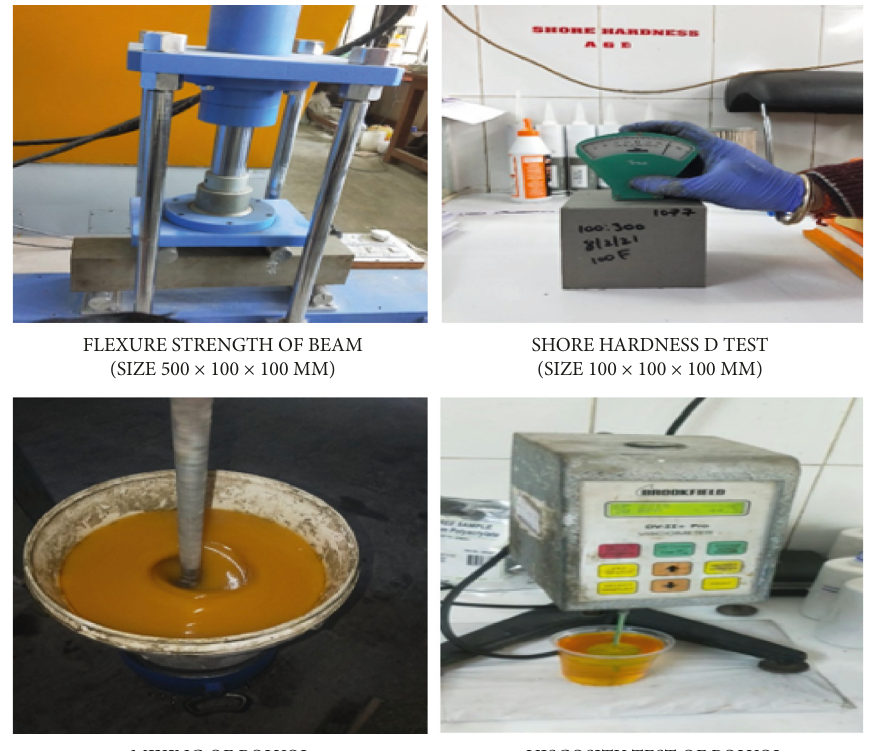
Figure 8: Polymer based lightweight concrete